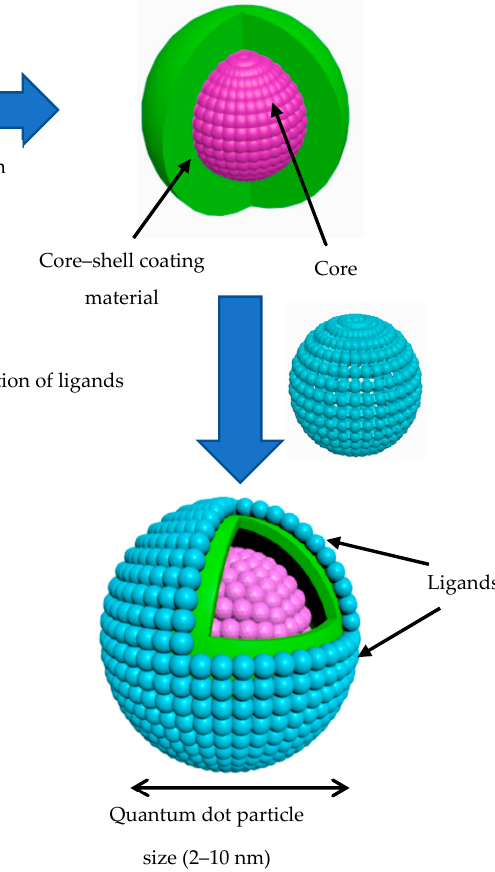
Figure 1. Quantum dot basic structure (core, shell, and ligands).